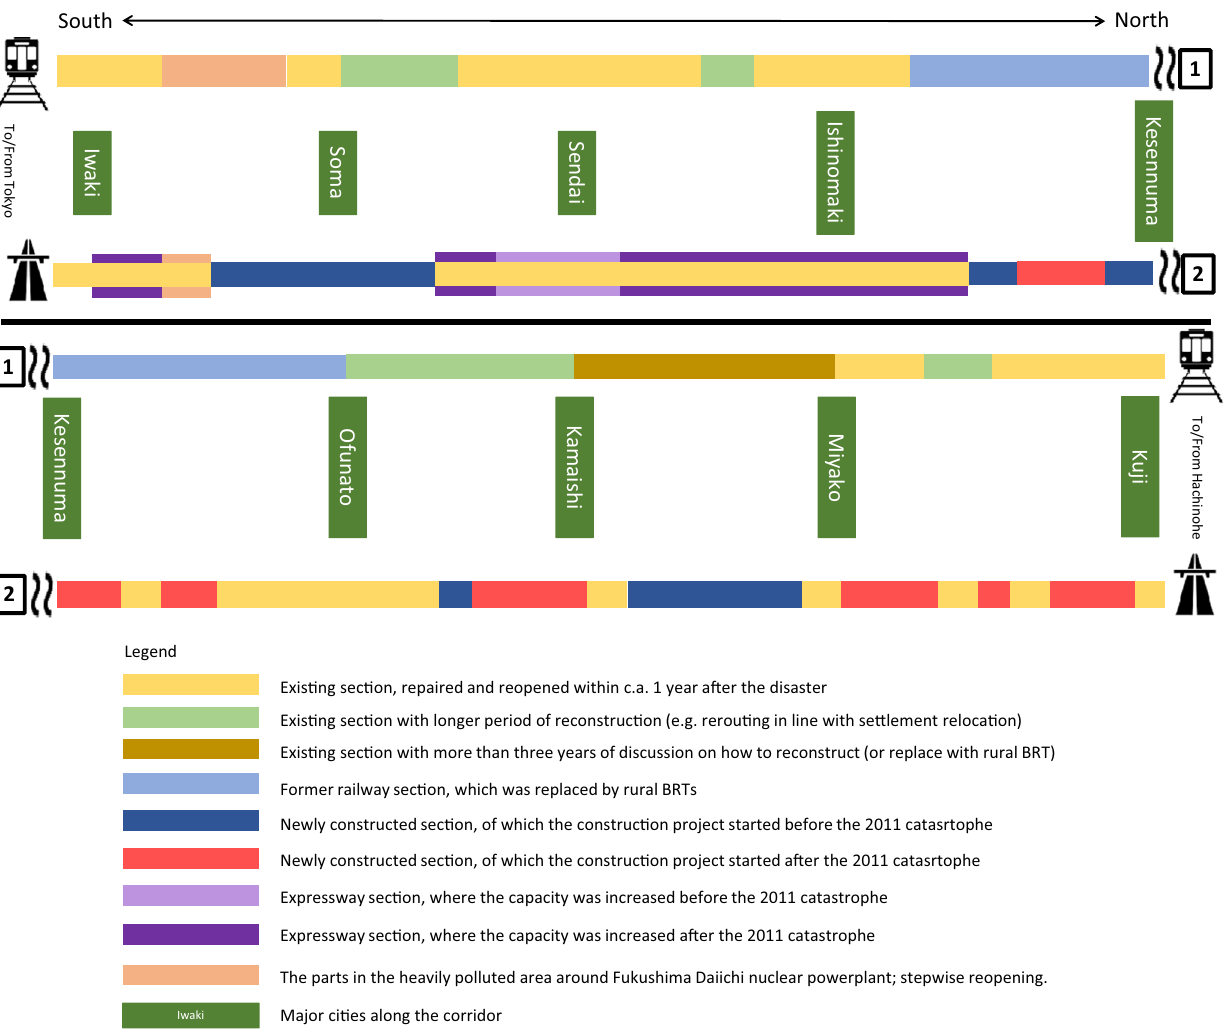
Fig. 3 Schematic comparison of the reconstruction situations between conventional railway and expressway after the 2011 catastrophe (Source: own